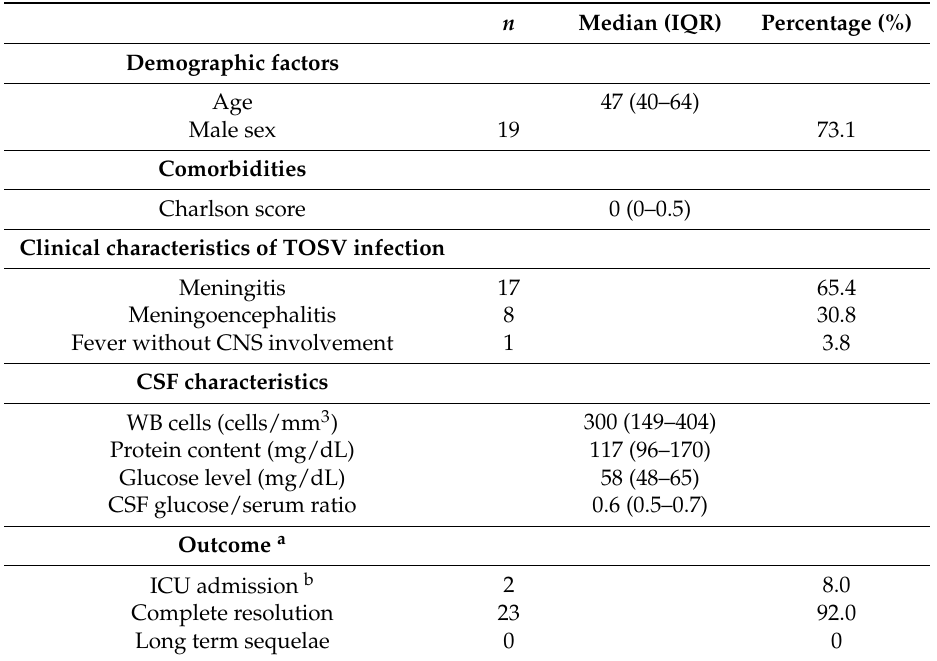
Table 1. Demographic variables, clinical data, cerebrospinal fluid characteristics and outcome of patients with TOSV infection. Total Patients n =